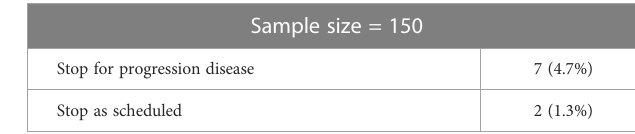
TABLE 1 Patients ’ characteristics.